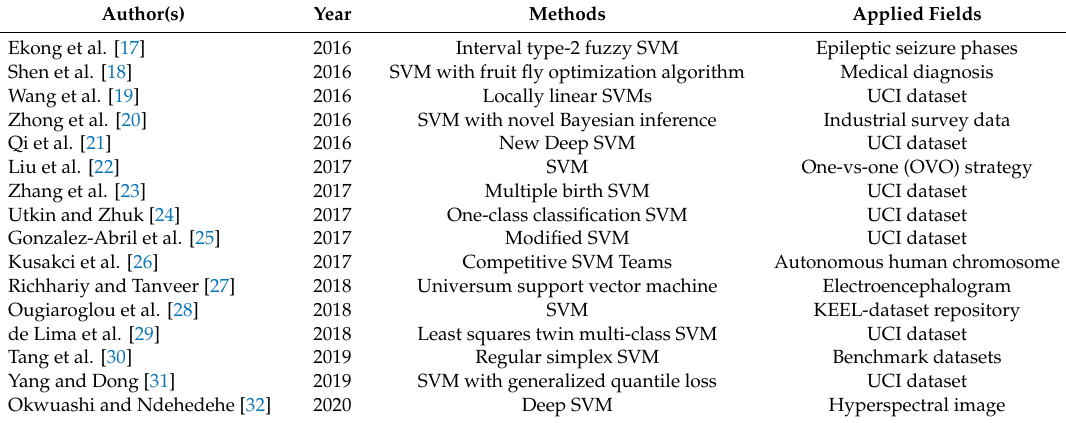
Table 1. Summary of studies of the support vector machine (SVM) methods conducted since